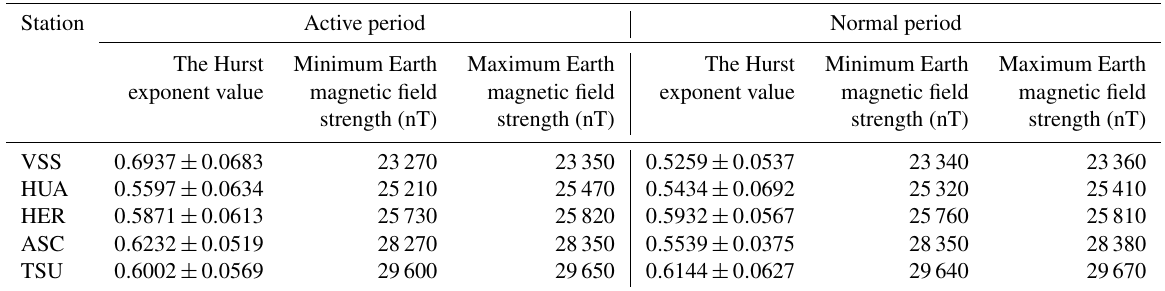
Figure 8. Periodogram for the SAA latitude region during the active period and normal period. Table 5. The Hurst exponent as well as the maximum and minimum strength of the Earth’s magnetic field during the geomagnetic storm (active period) and normal period for the station in the SAA